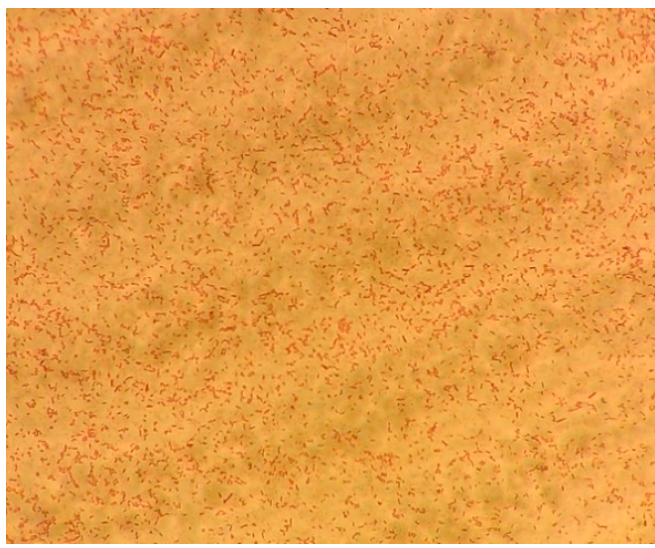
Figure 3. Intralesional acid-fast rod-shaped bacteria with Ziehl–Neelsen staining. Mycobacterium lentiflavum and Mycobacterium szulgai strains were cultured from the liver tissue. Colonies visible on the solid media (S and P) were smooth with typical moist characteristics. The isolates on the P medium were more glistening and yellow. These were accompanied by a number of other bacteria: Aeromonas hydrofila , Citrobacter freundii , Providencia rettgeri , and Salmonella